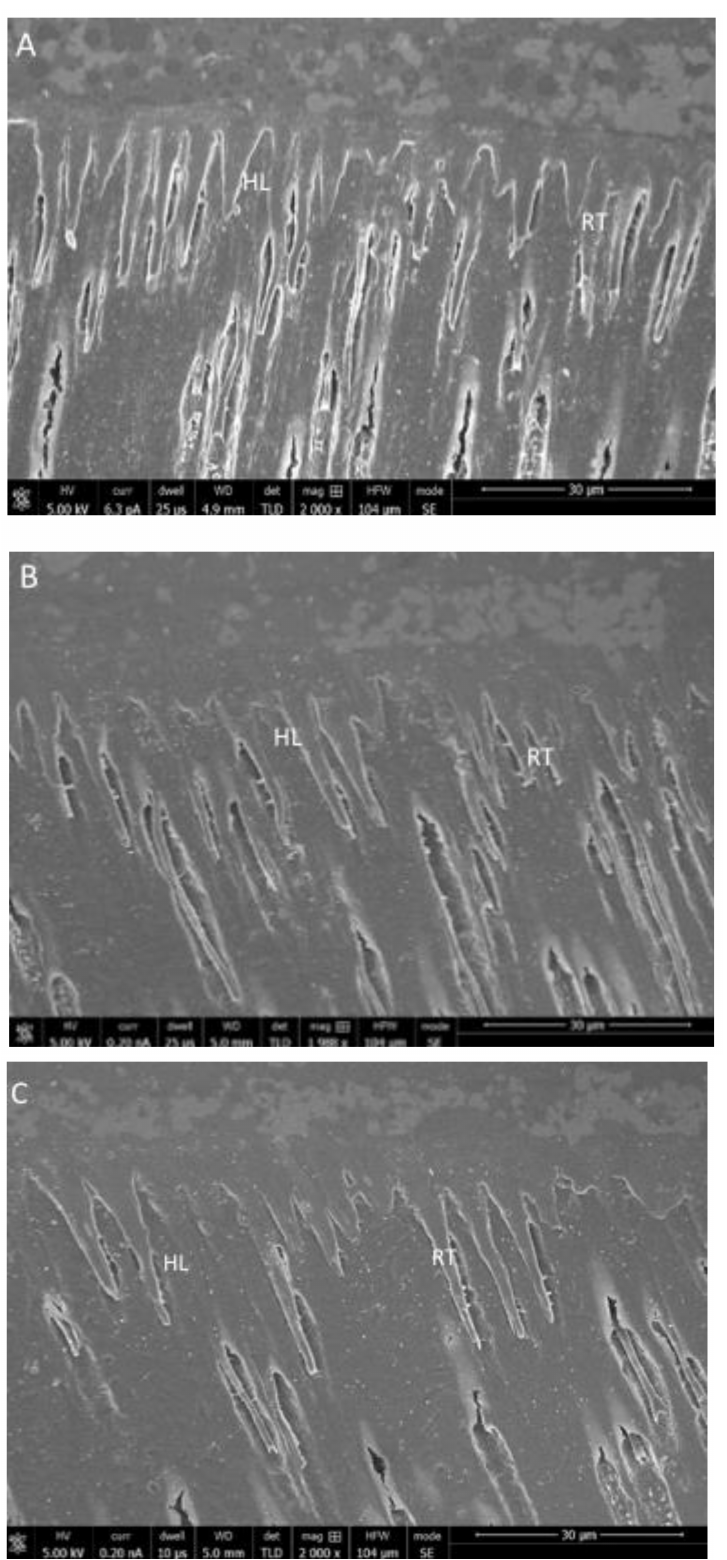
Figure 4. SEM images of bonded dentin specimen ( A ) rGO-5%- NaOCl group specimens showing classic hybrid layer (HL) formation with high number of resin tags in dentin. ( B ) rGO-5%-PDT group specimens showing standard HL formation with average number of resin tags ( C ) rGO-5%-ECYL group specimens displaying lower than average resin tags on the dentin surface at the